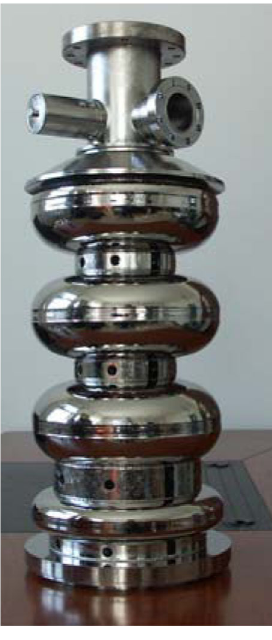
FIG. 5. (Color) 3.5-cell large grain niobium cavity after 1250 (cid:3) C post-purification and BCP at Ningxia.